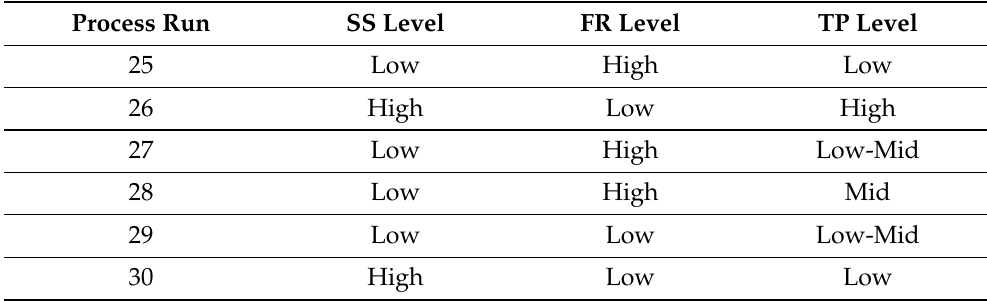
Table 3. Factor levels (SS = screw speed; FR = feed rate; TP = temperature profile) for runs 25–30 (independent external test